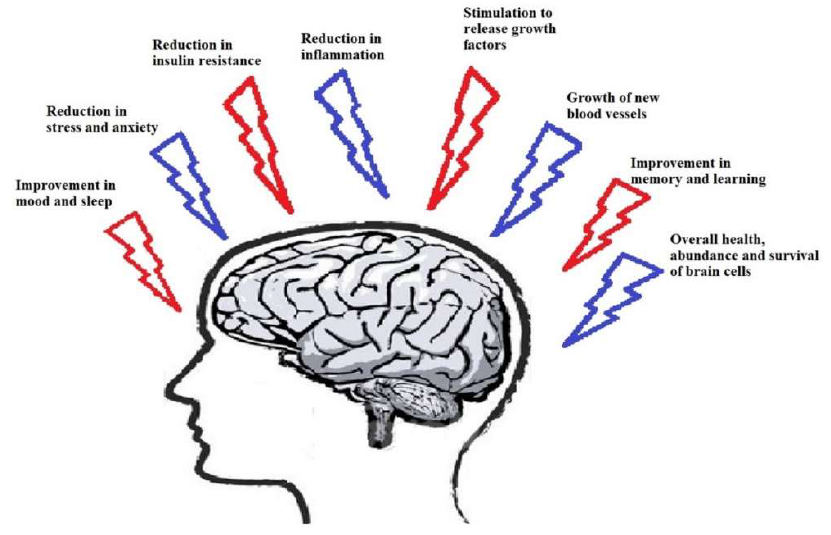
ff ects of exercise on the human Figure 1. Effects of exercise on the human brain. Figure 1. E